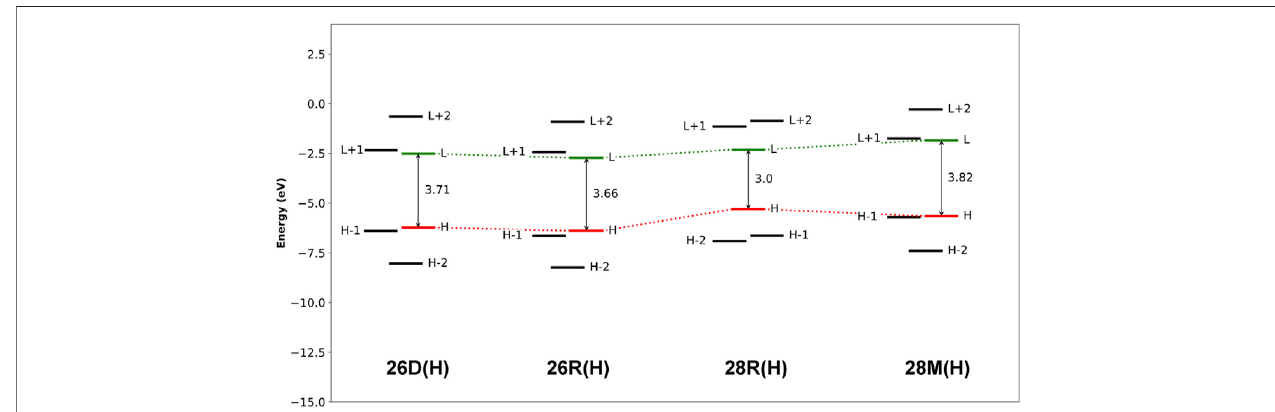
FIGURE 4 | Molecular orbital diagrams computed at the CAM-B3LYP/6-311+G(d,p) level of theory.